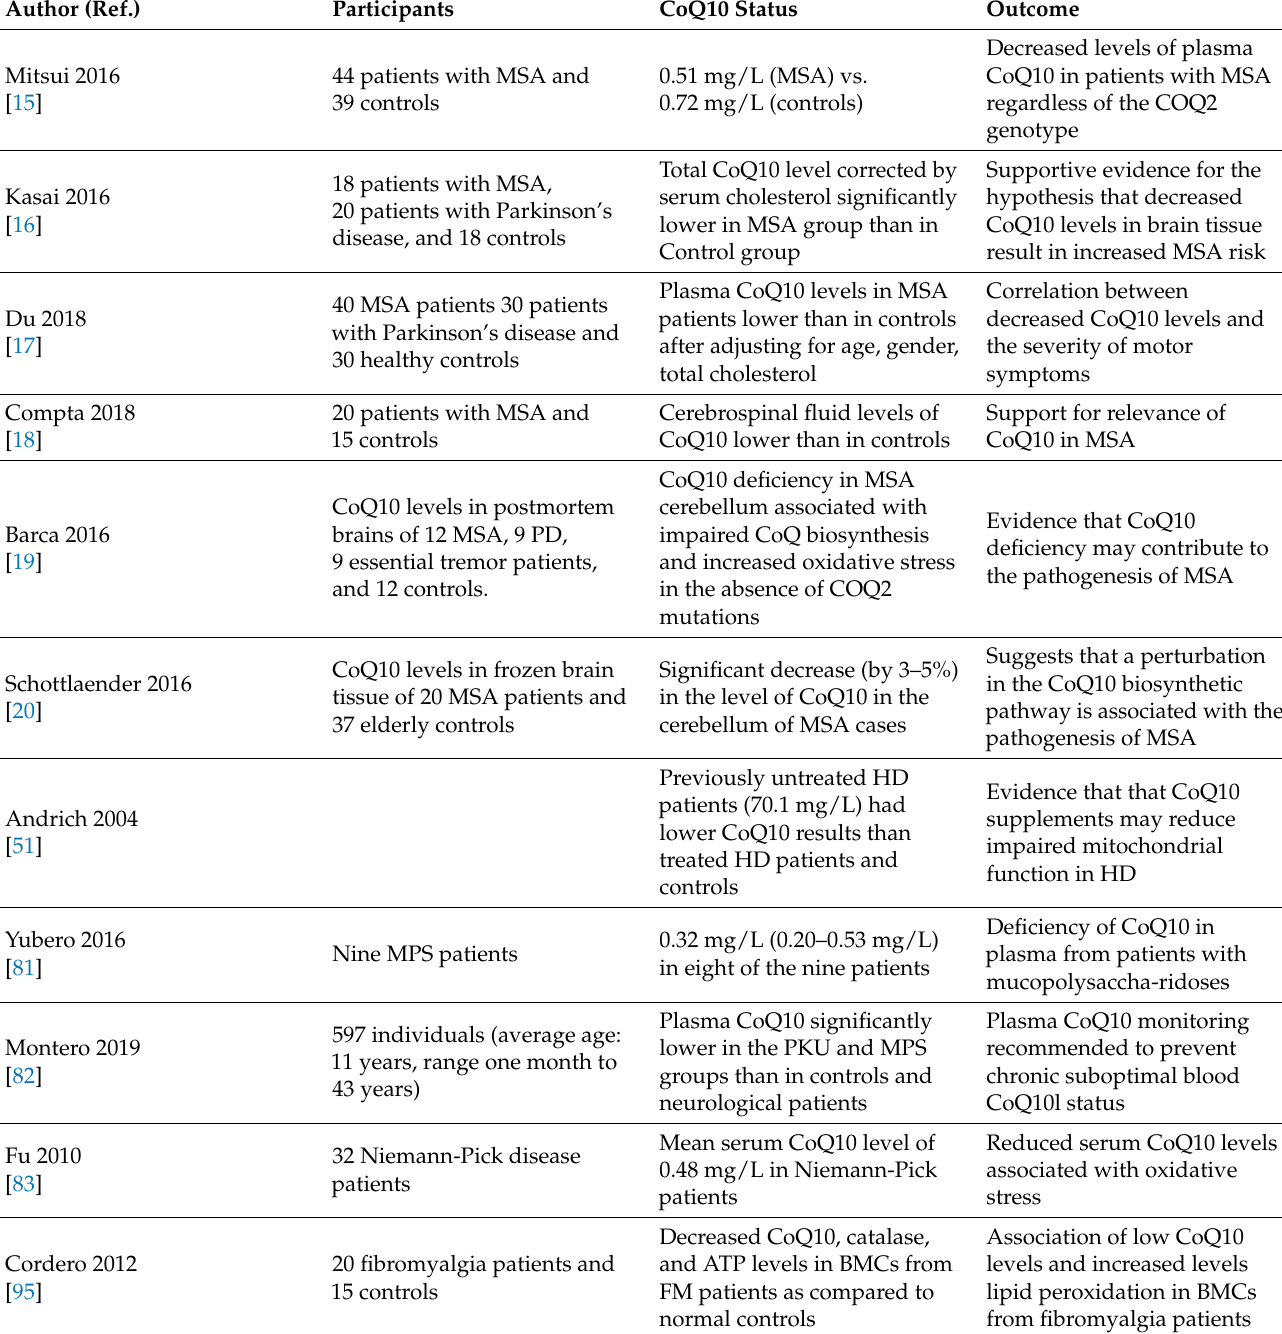
Table 1. Clinical Trials: Coenzyme Q10 Status in Less Common Age-Related